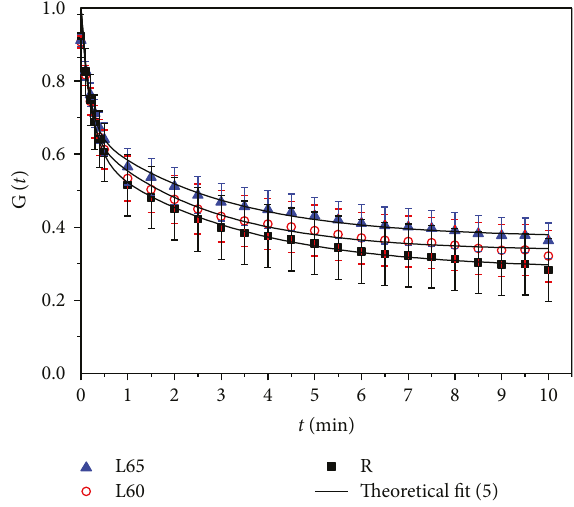
Figure 9: Stress-relaxation curves of corneal